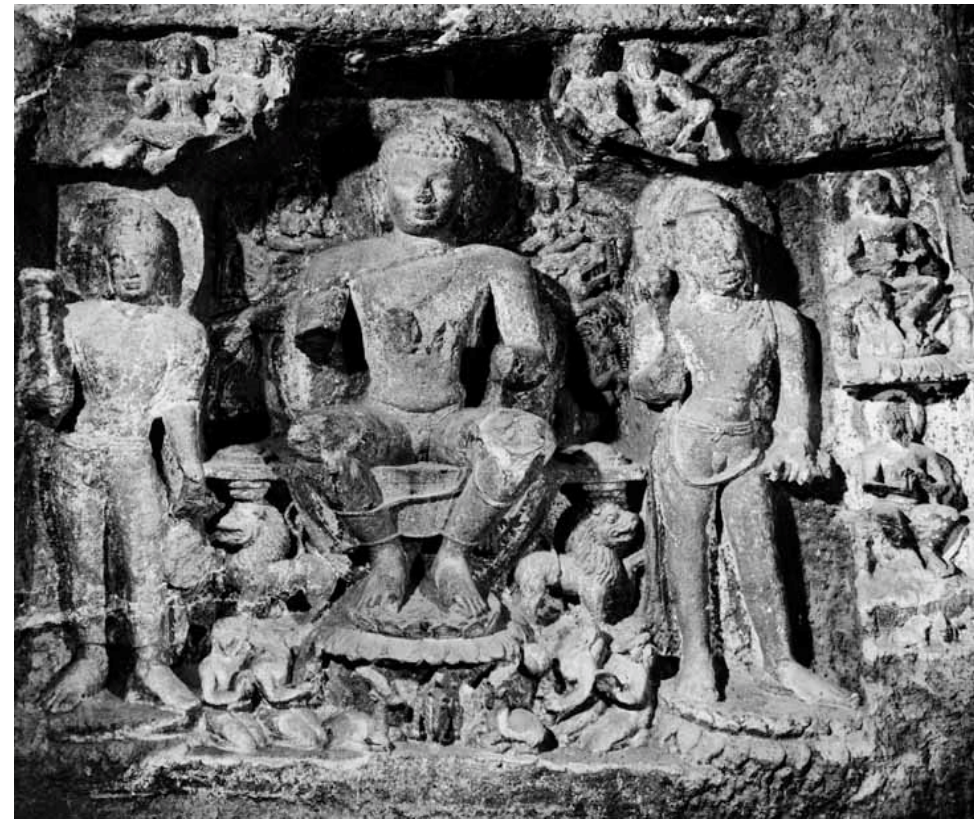
Figure 8. Intrusive Buddhist triad from Aja ṇṭ ā Cave 22, main shrine, ca. 478–480 CE (Courtesy of AIIS # 96809).